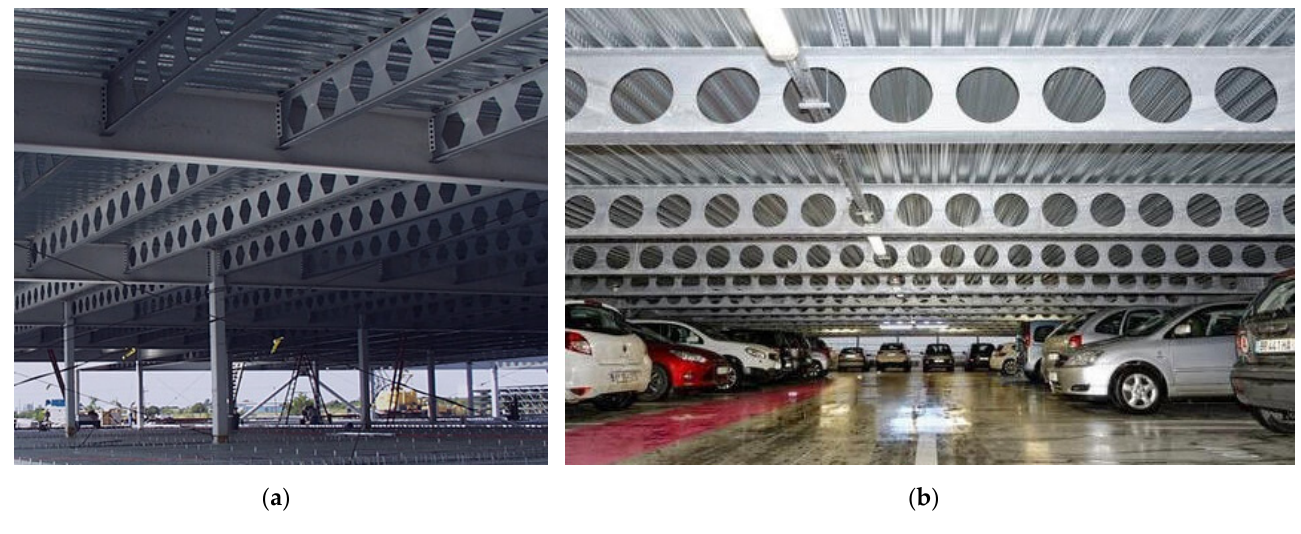
Figure 4. Applications of composite alveolar beams [14]: ( a ) With castellated section; ( b ) With cellular section.